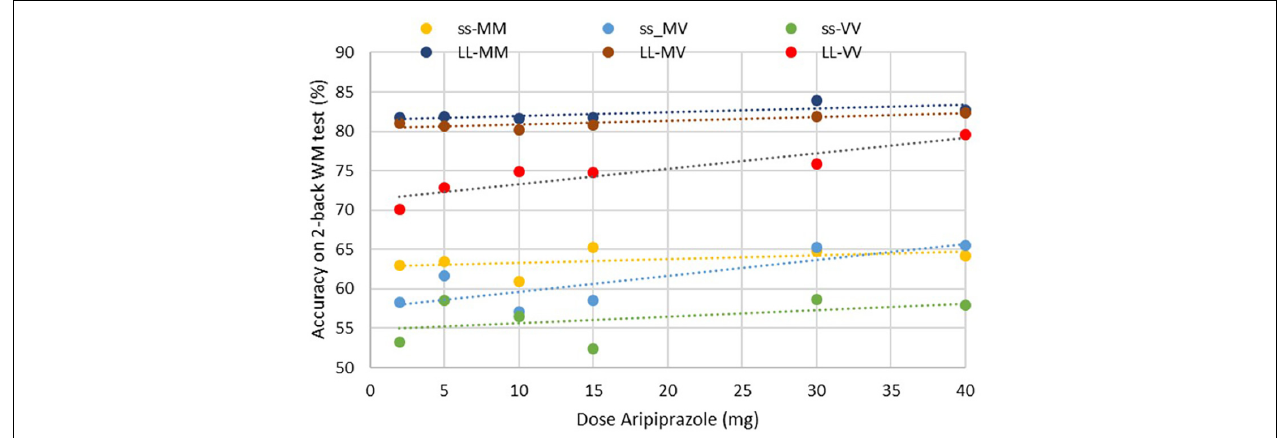
FIGURE 5 | Effect of COMT and 5-HTTLPR rs25531 genotypes on aripiprazole dose-response on simulated cognitive outcome for schizophrenia patients. Most COMTMM-5HTT patients have an essentially flat dose-response and performs quite well; in contrast for COMT VV subjects and to a lesser extent for COMTMV subjects, higher aripiprazole doses significantly improve cognitive outcome.